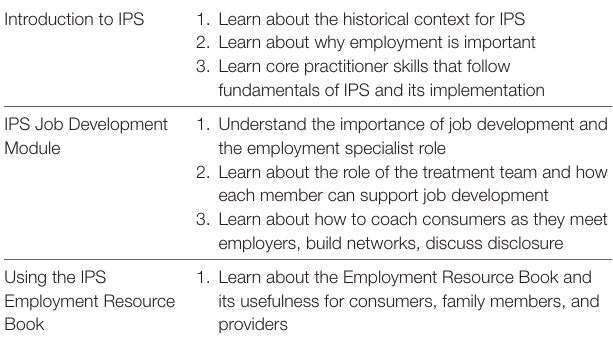
taBle 1 | Learning objectives for individual placement and support (IPS)